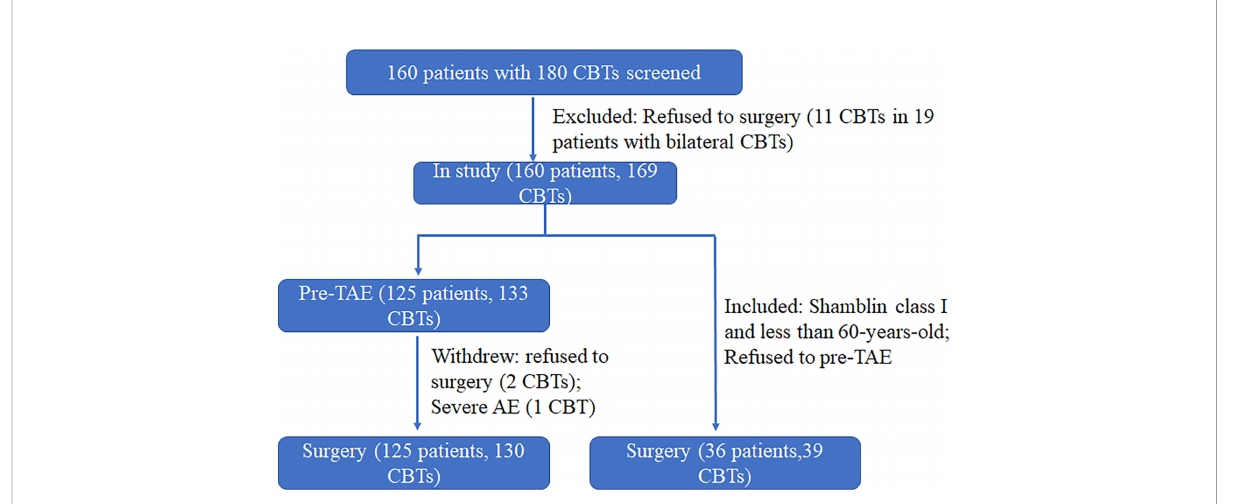
FIGURE 1 Patient fl ow chart. CBTs, carotid body tumors. Pre-TAE, Preoperative transarterial embolization.